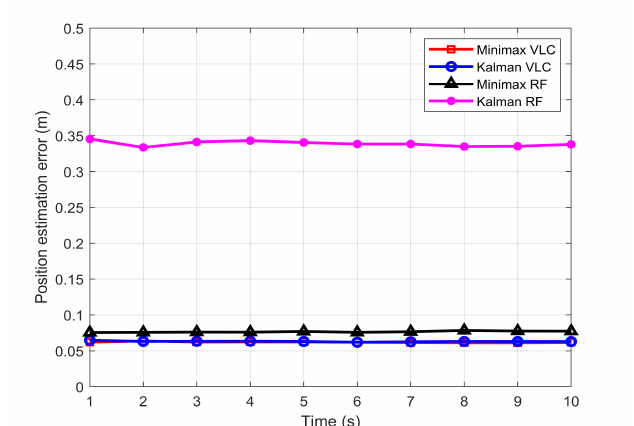
Figure 8. Comparison between the position estimation errors from minimax and Kalman filters using RF and VLC.